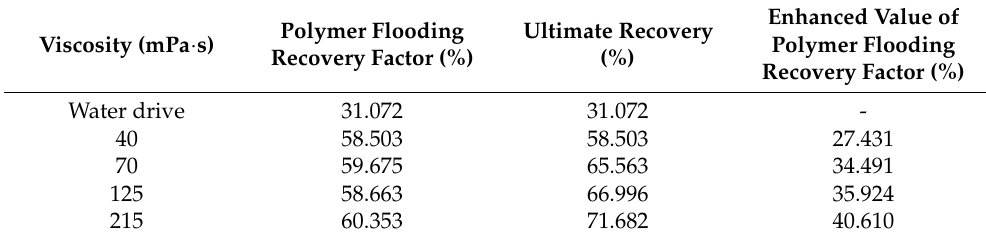
Table 2. Recovery efficiency from flooding with polymer with different viscosities.